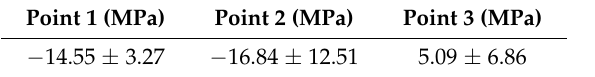
Figure 3. Layout of measurement points. Table 1. Residual stress measured by X-ray. Figure 2. Residual stress measurement by X-ray.